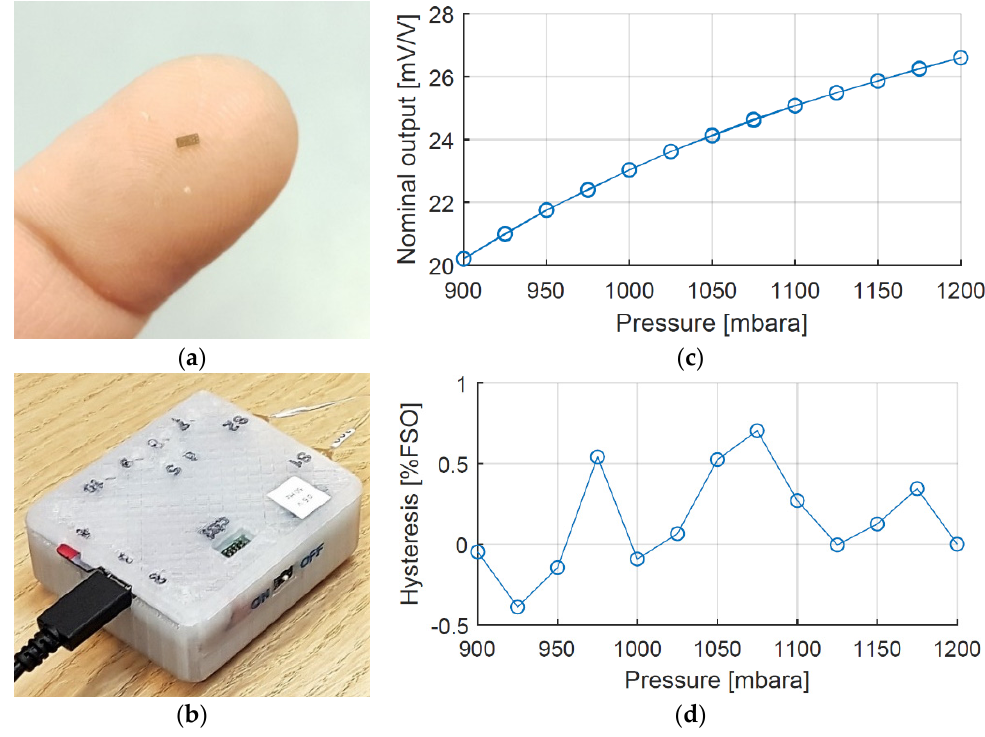
Figure 3. ( a ) A MEMS sensor element designed for in vivo applications; ( b ) Custom ‐ made Sensor Data Logger (SDL) with two sensor probes connected; ( c ) A typical calibration curve from 900 to 1200 mbar